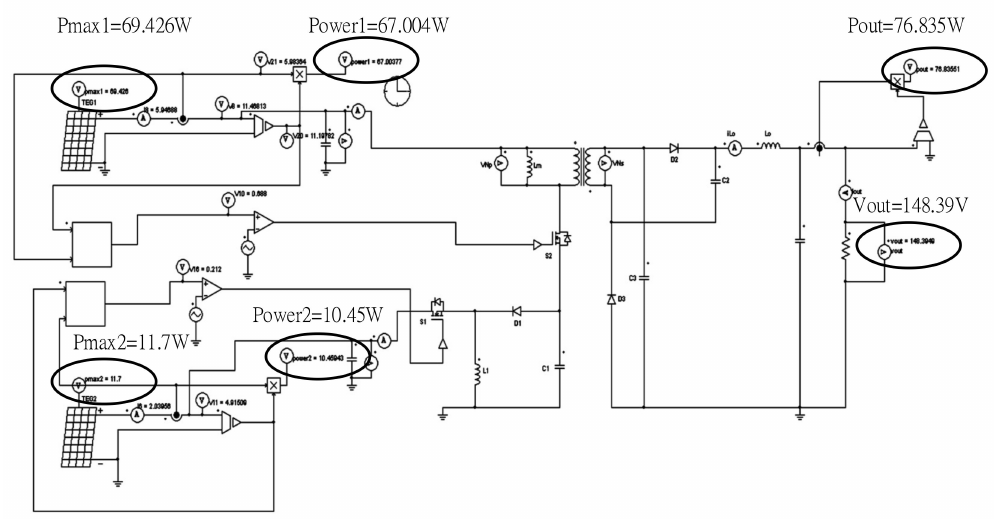
Figure 18. Simulation example 2.